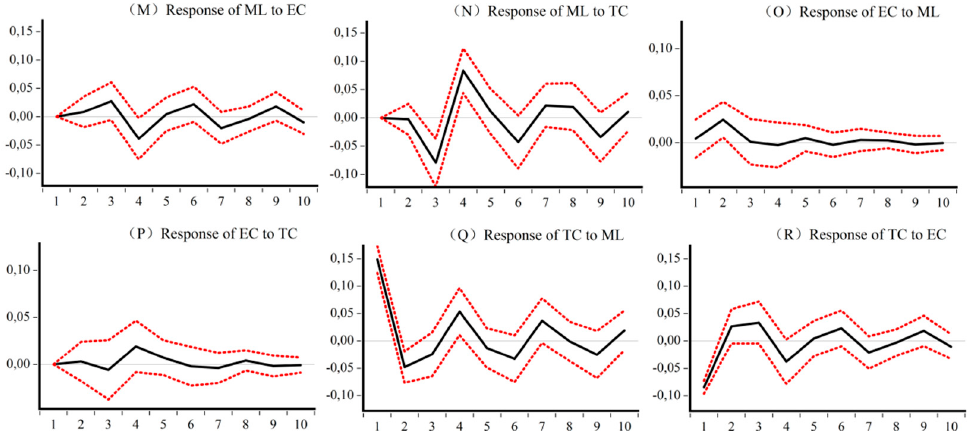
Figure 7. Impulse response results of ML, EC, and TC of Central CEE. ( M ) Response of ML to EC ( N ) Response of ML to TC ( O ) Response of EC to ML ( P ) Response of EC to TC ( Q ) Response of TC to ML ( R ) Response of TC to EC.